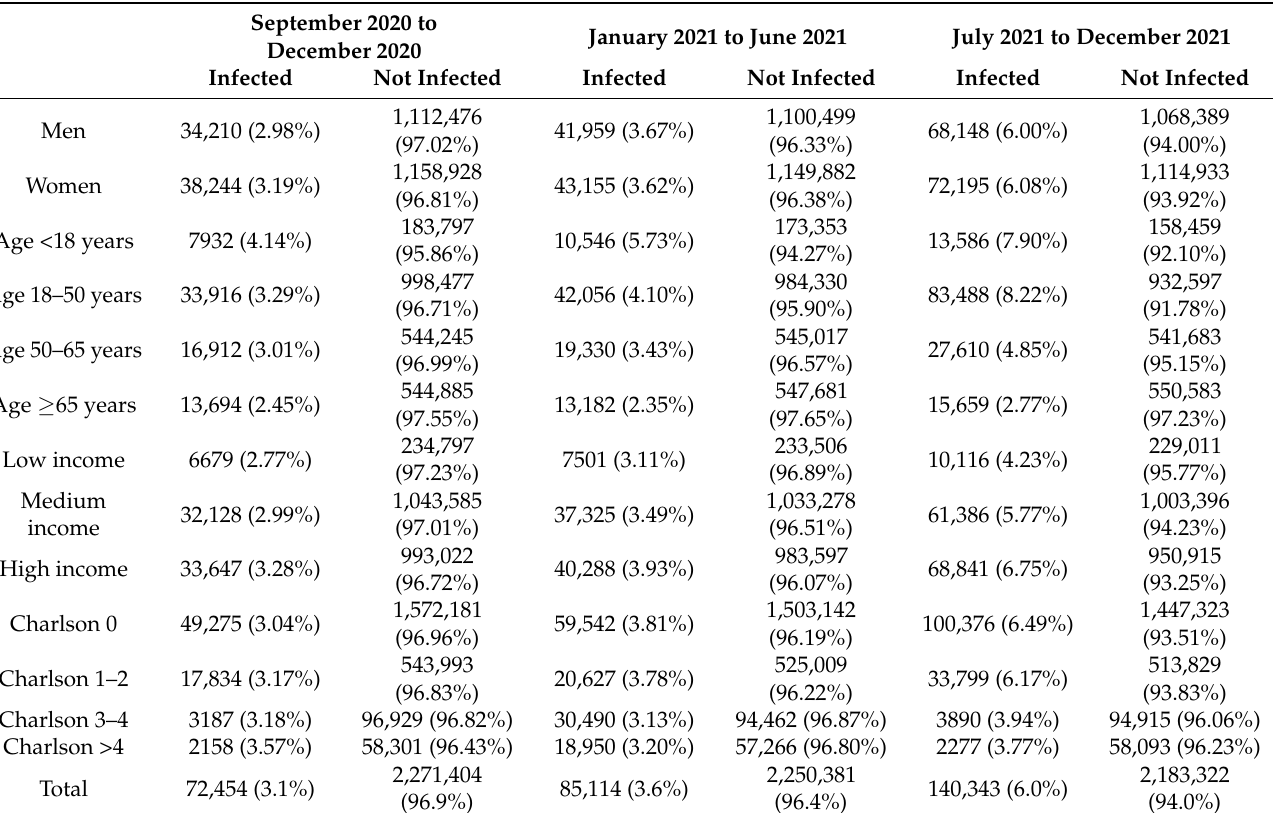
Table 1. Characteristics of infected and uninfected individuals during late 2020 and the first and second halves of 2021. Charlson: Charlson Comorbidity Index.